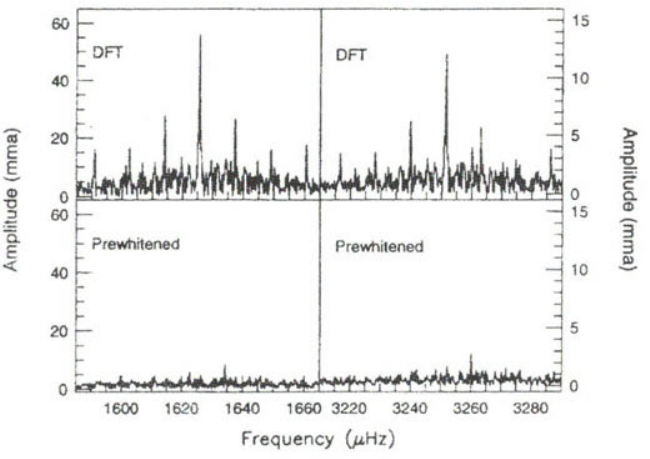
Fig. 9. The 615 s and first harmonic region with the main peak removed from the data (X2N88